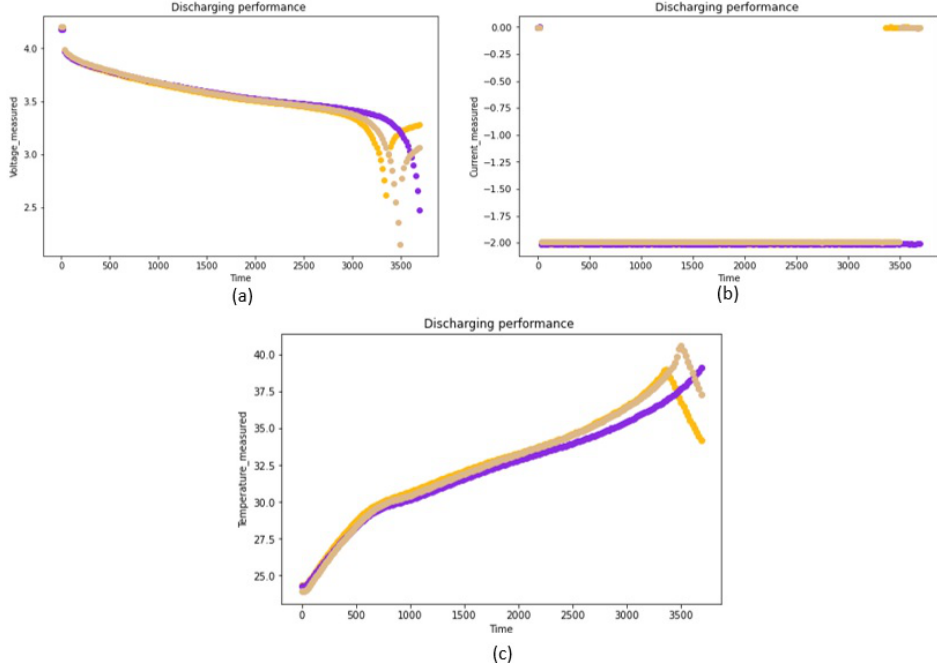
Figure 7. The process of discharging the battery. ( a ): battery a discharging curve performance; ( b ): battery b current discharging performance; ( c ): battery c discharging temperature curve perfor- mance.